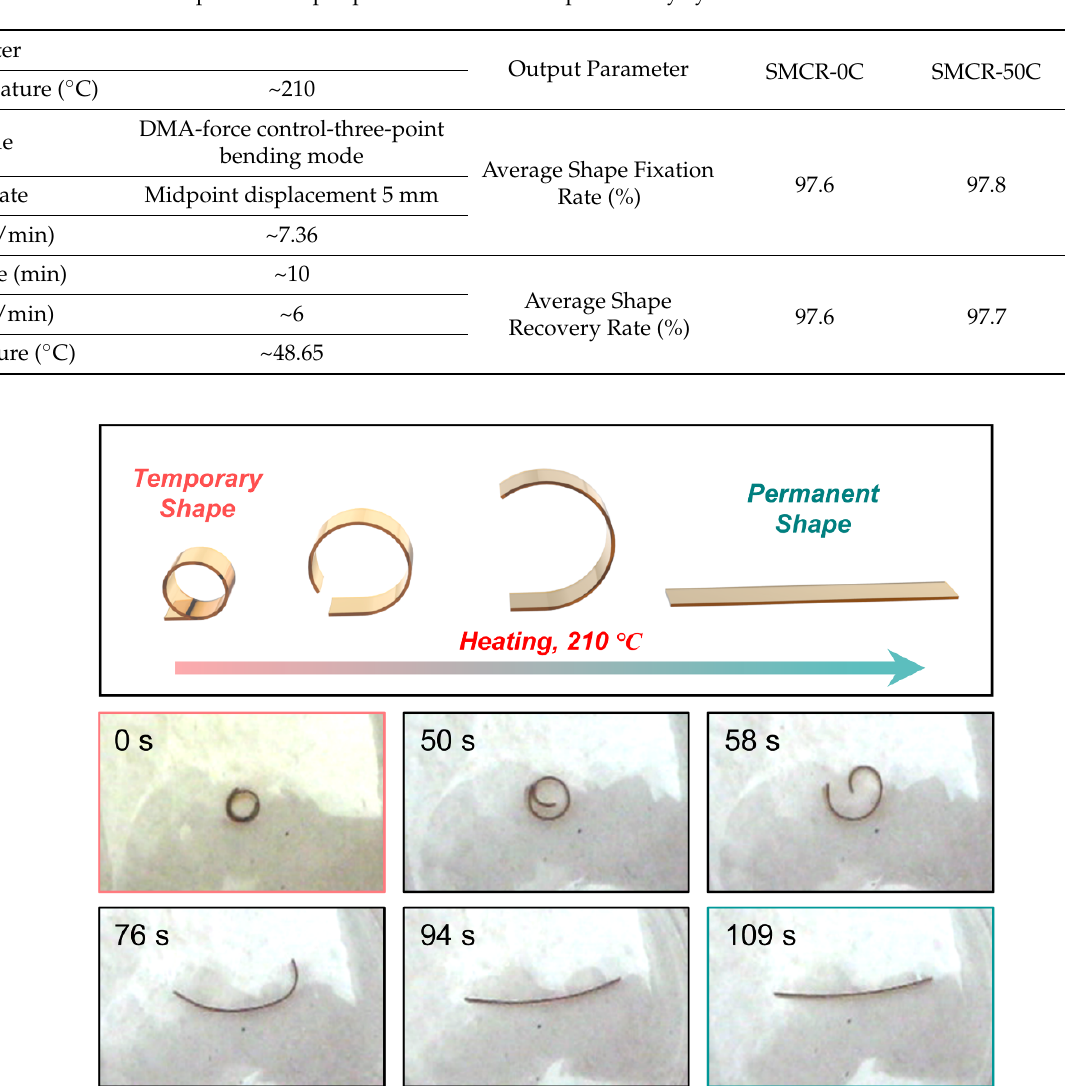
Table 1. Input and output parameters of the shape memory cycle.